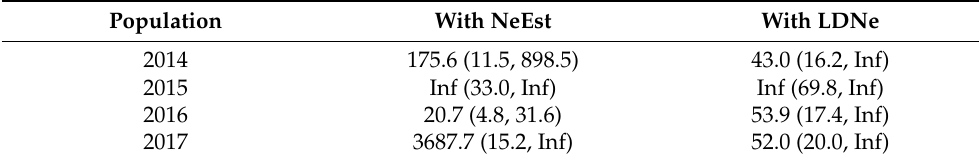
Table 5. Effective population size (Ne) and 95% CIs based on Linkage disequilibrium.